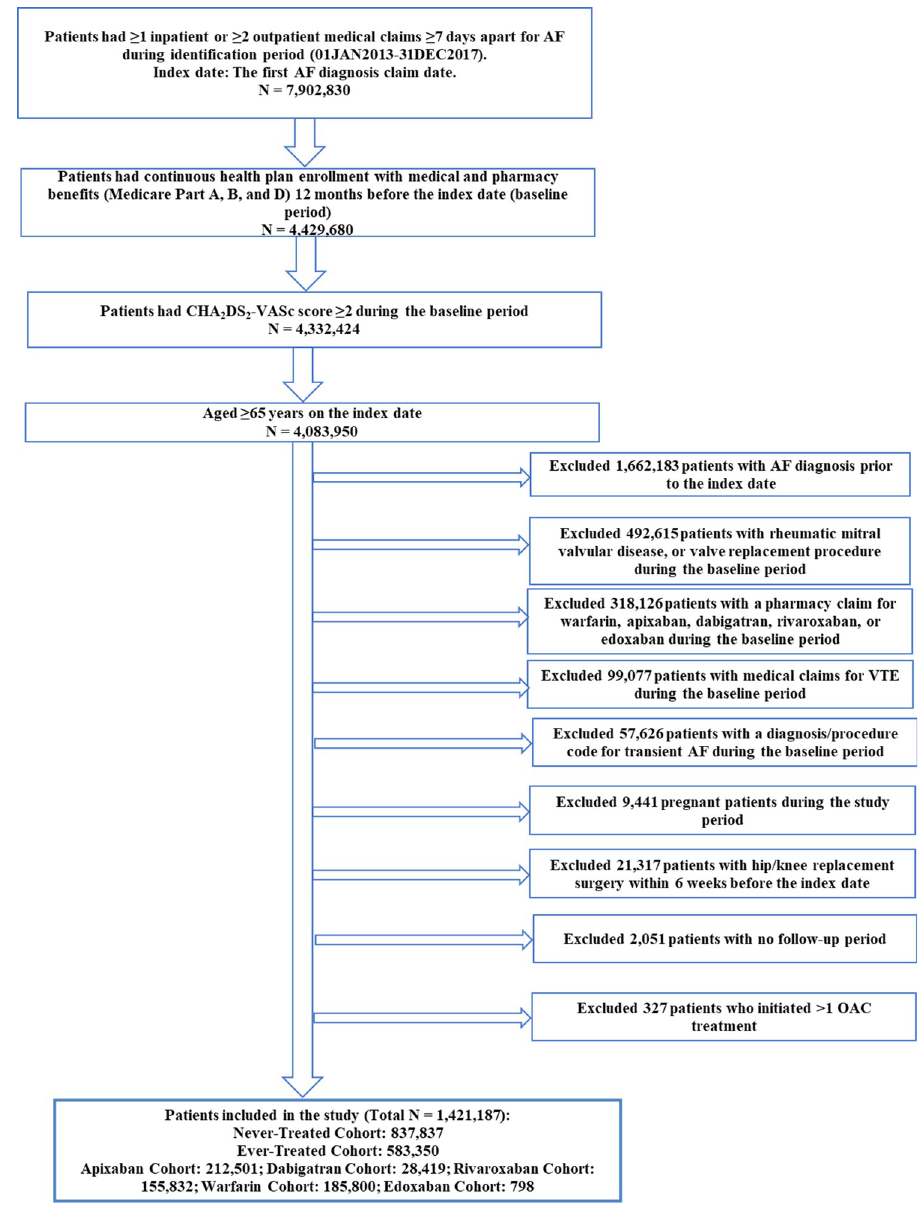
Fig 1. Patient selection criteria. AF- Atrial Fibrillation; CHA2DS2-VASc- Congestive heart failure, Hypertension, Age � 75 years, Diabetes mellitus, Stroke, Vascular disease, Age 65–74 years, Sex category; ICD-9/10-CM.